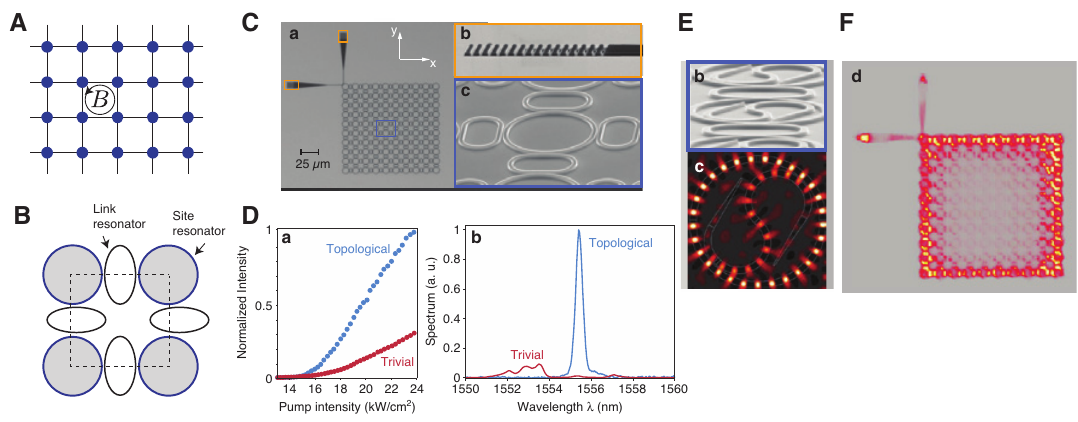
Figure 8: 2D topological microring cavity laser. (A) A schematic picture of the Harper-Hofstadter model. A particle hopping around a plaquette of the lattice acquires a phase B . (B) How to construct a plaquette of the Harper-Hofstadter model with resonators. Site resonators are connected by link resonators, which are anti-resonant with modes of the site resonators. Link resonators connecting site resonators horizontally are positioned symmetrically with respect to hopping to right and left, whereas link resonators connecting vertical sites are asymmetrically positioned. This asymmetry introduces different optical paths for photons going up with respect to those going down, resulting in an effective hopping phase upon vertical hopping. (C) Image of the experiment of Ref. [31]. The Harper-Hofstadter model with 10 × 10 lattice sites are constructed. There are output couplers at the upper left corner. (D) Intensity of the emission when the perimeter of the system is pumped as a function of (a) pump intensity and (b) wavelength. (E) Resonators with S-shaped waveguides. The lower figure is the numerically calculated field distribution of a resonator with an S-shaped element. (F) Experimentally measured intensity profile of the lasing edge mode from the topological Harper- Hofstadter model made of resonators with S-shaped elements. The intensity difference in the output couplers indicate that the chiral edge state propagating in the counter-clockwise direction has much higher intensity than that propagating in the opposite direction. (C–F) Adapted from Ref.